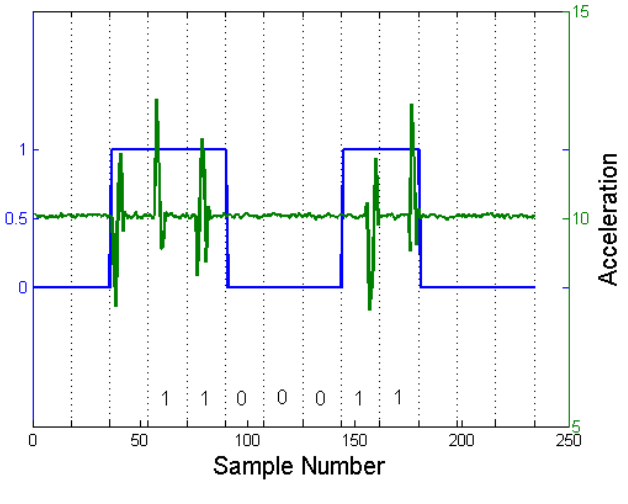
Figure 5. The x -axis indicates the successive input acceleration readings. The y -axis on the left side indicates the calculated binary signal for each frame, and the right side shows the raw accelerometer